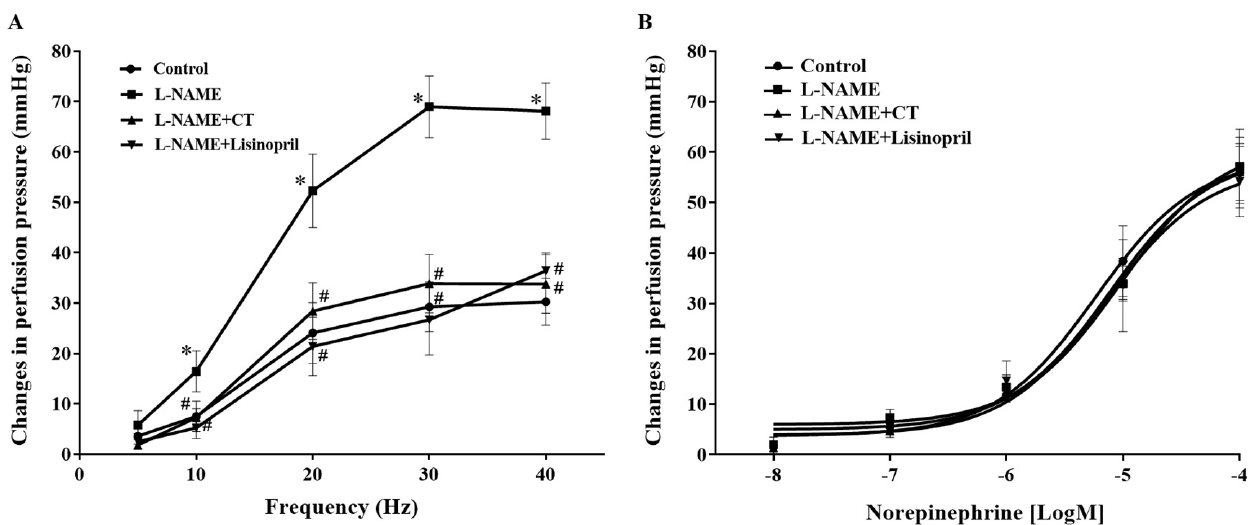
Figure 3. Effects of CT extract and lisinopril on contractile responses to electrical field stimulation ( A ) and exogenous norepinephrine ( B ) in mesenteric vascular beds collected from all groups in the experiment. Data are expressed as mean ± SEM ( n = 8/group), * p < 0.05 vs. control, # p < 0.05 vs. L-NAME. CT: Clitoria ternatea Linn. extract.